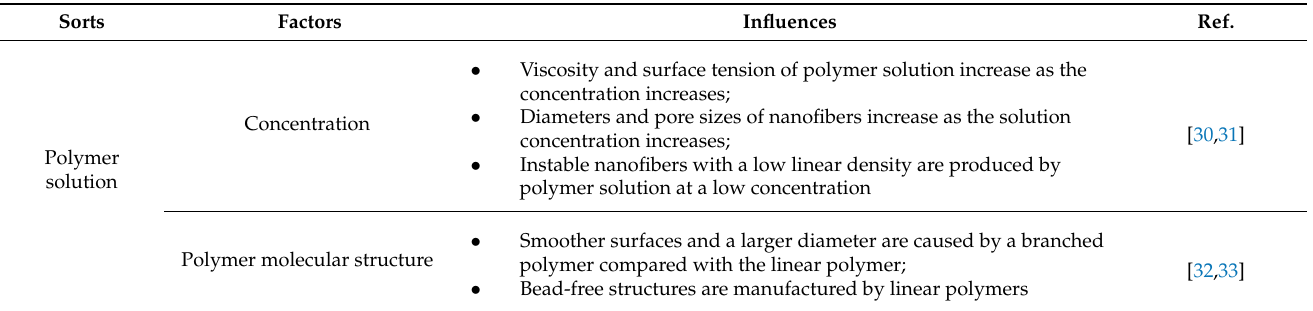
Table 2. Effects of different conditions on the nanofibers in electrospinning